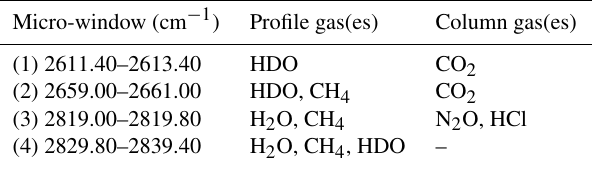
Table 1. Micro-windows for H 2 O retrieval including interfering gases retrieved within those micro-windows. Column gases are those retrieved by profile scaling of the initial profile while profile retrieval is performed for the profile gases